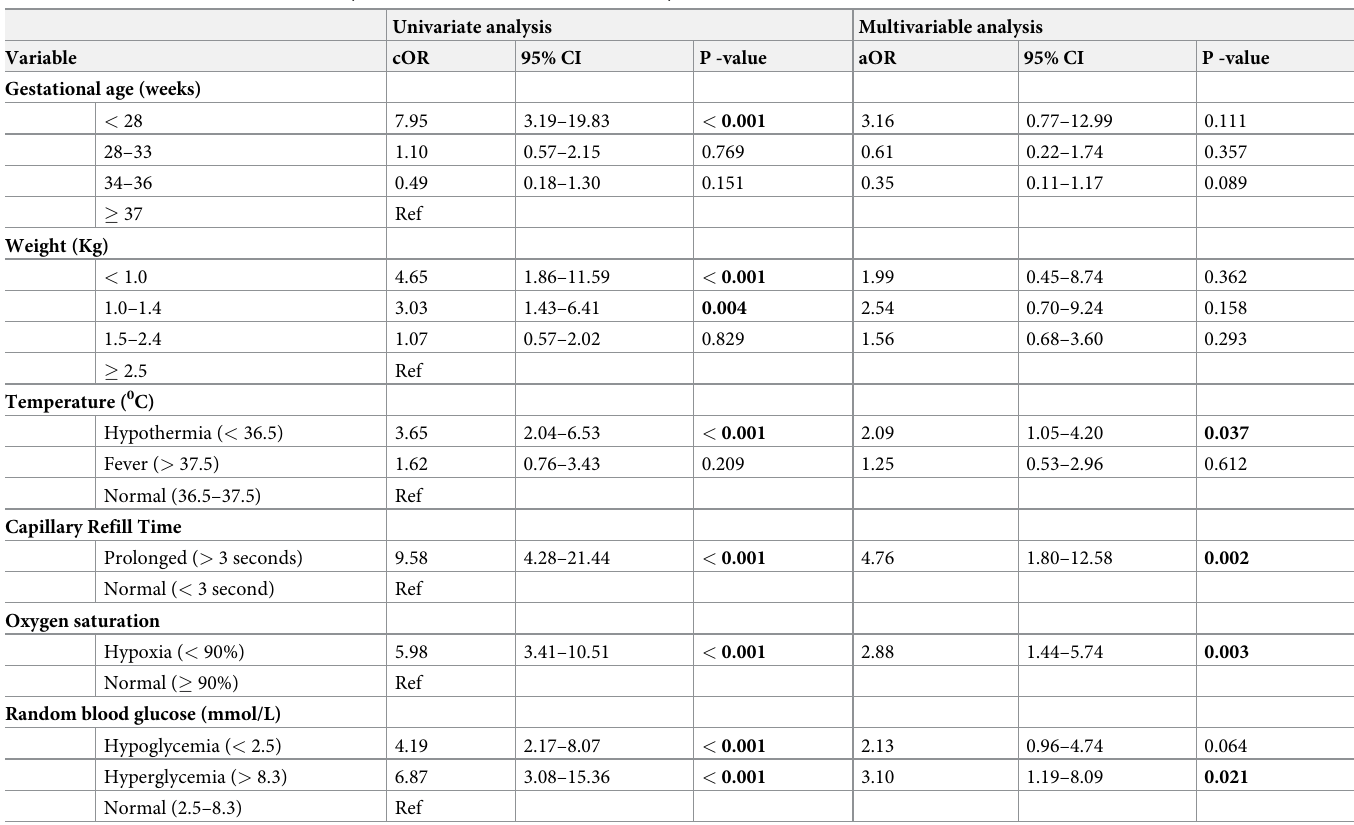
Table 2. Univariate and Multivariate analysis of factors associated with